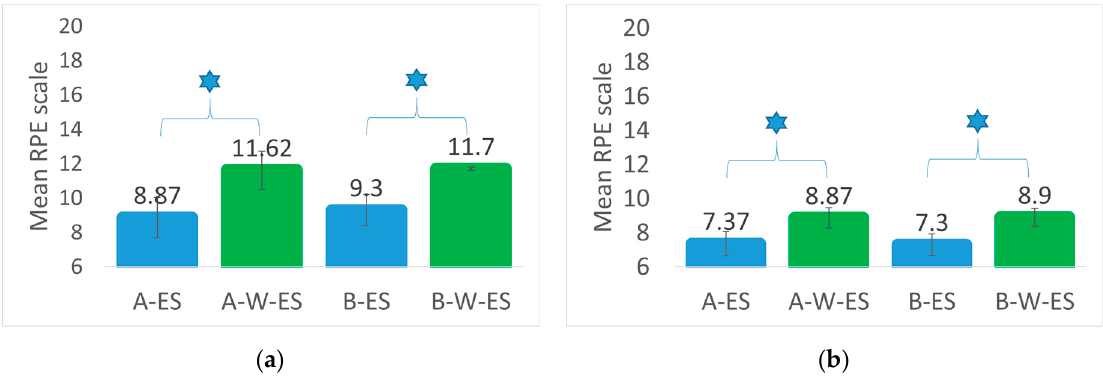
Figure 5. Mean RPE scale of the upper limb for groups A and B with and without using the PULE for: ( a ) fruit thinning simulation; ( b ) pesticide spraying simulation. The star symbol indicates statistical significance ( α < 0.05).